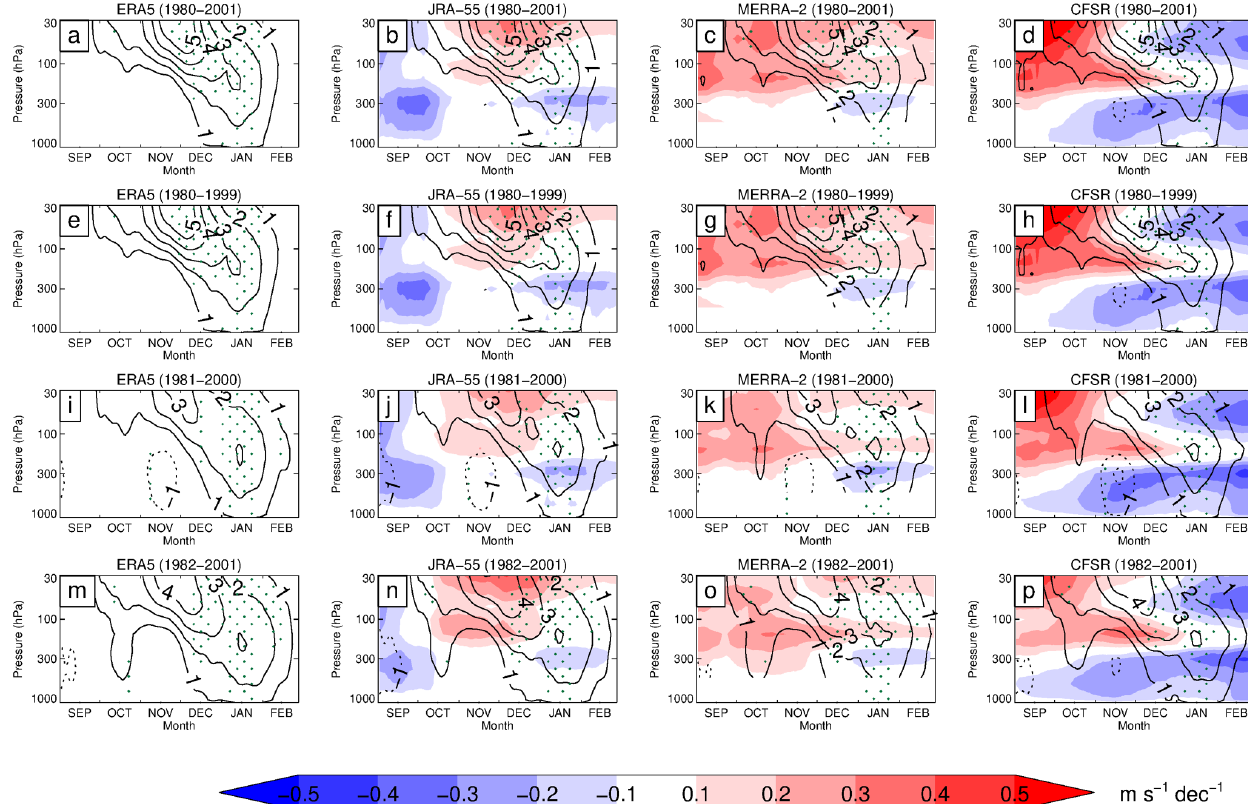
Figure 9. Sensitivity of the trend in zonal wind to time period, displayed as the time–height cross section of the trend in the zonally averaged zonal wind (contour intervals: 1, 2, 3, 4, and 5ms − 1 per decade) averaged over 50 to 70 ◦ S from 1980 to 2001 (a–d) , 1980 to 1999 (e–h) , 1981 to 2000 (i–l) , and 1982 to 2001 (m–p) for ERA5, JRA-55, MERRA-2, and CFSR. The shading represents differences from ERA5 at intervals of ± 0.1, ± 0.2, ± 0.3, ± 0.4, and ± 0.5ms − 1 per decade. Results in the range 500 to 1000hPa are not included in panels (c) , (g) , (k) , and (o) . Panels (a) – (d) are the same results as shown in Fig. 2. Stippling denotes regions where the trends are significant at the 5% significance level. Note that for each panel the time series is